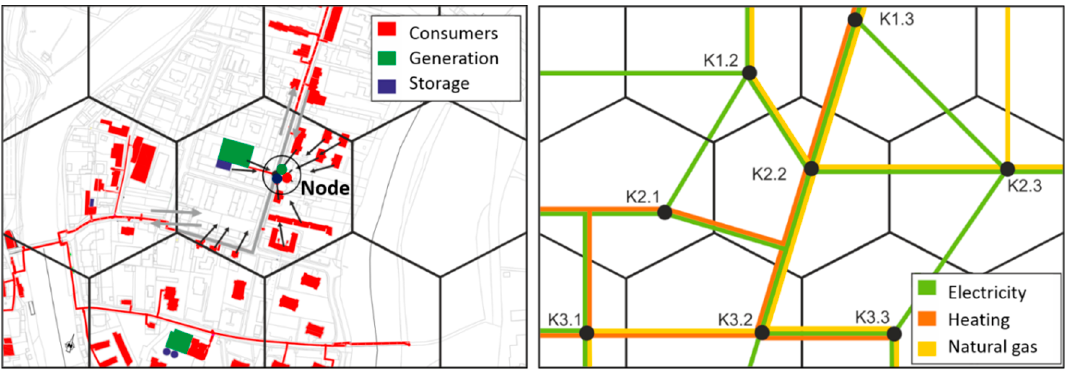
Figure 1. Visualization of exemplary process steps within the cellular approach.